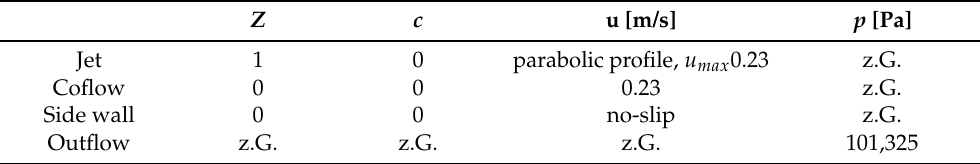
Table 2. Boundary conditions. z.G. stands for zero normal gradient. Z c u [m/s] p [Pa] Jet 1 0 parabolic profile, u max 0.23 z.G. Coflow 0 0 0.23 z.G. Side wall 0